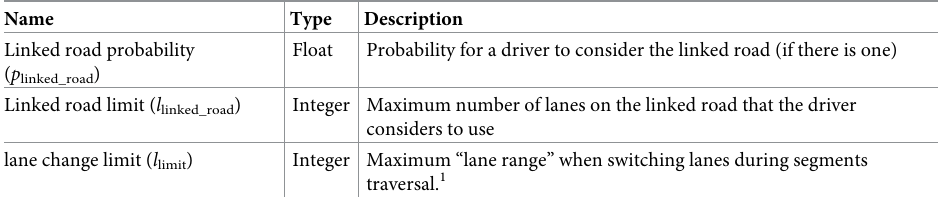
Table 7. Selection of candidate lane